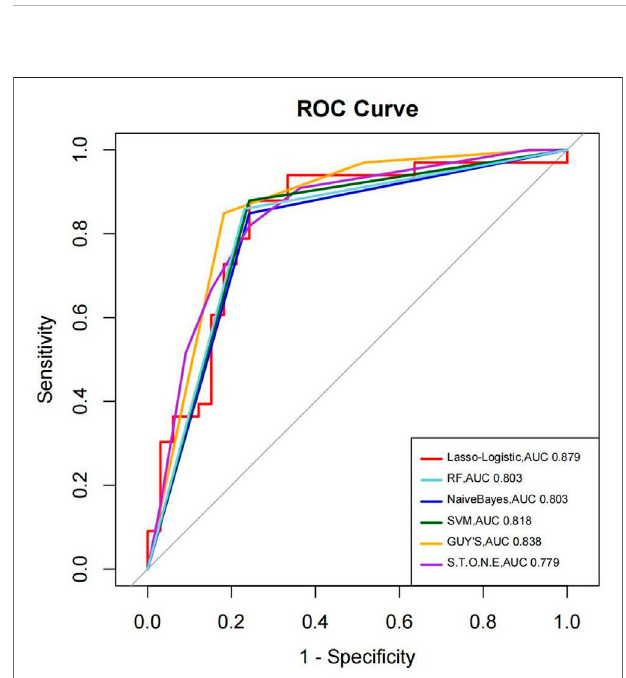
FIGURE 3 | The ROC curves of the four MLMs as well as the GSS and S.T.O.N.E score system.